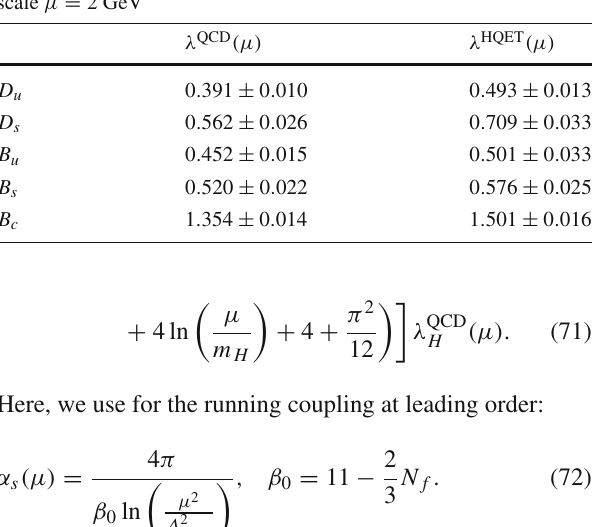
Table 5 The inverse moments λ QCD (μ) and λ HQET (μ) in GeV at